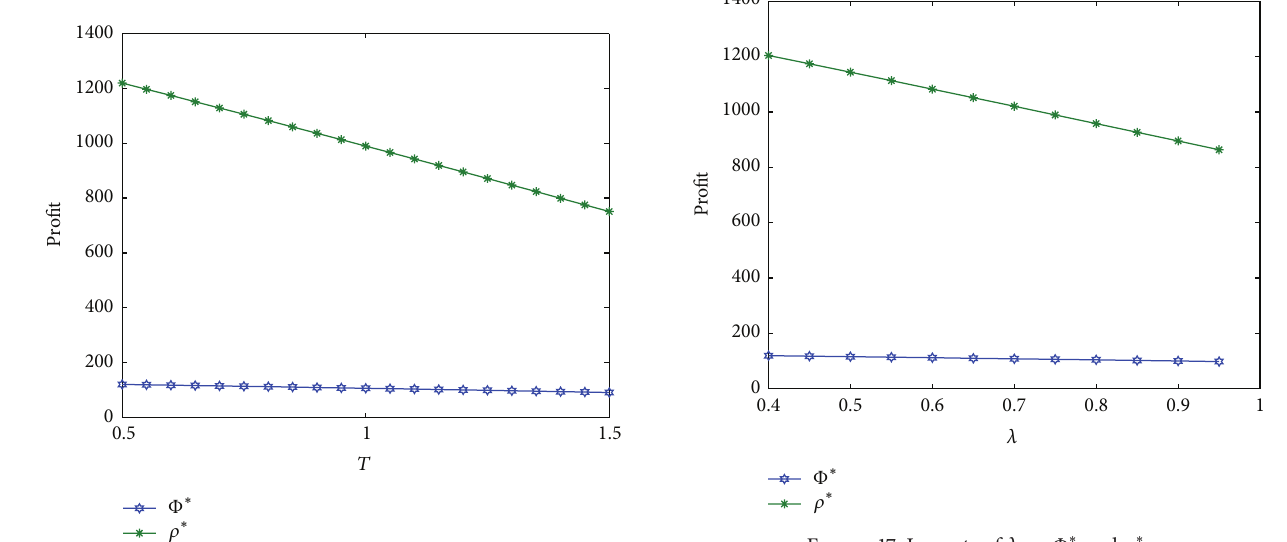
Figure 17: Impacts of 𝜆 on Φ ∗ and 𝜌 ∗